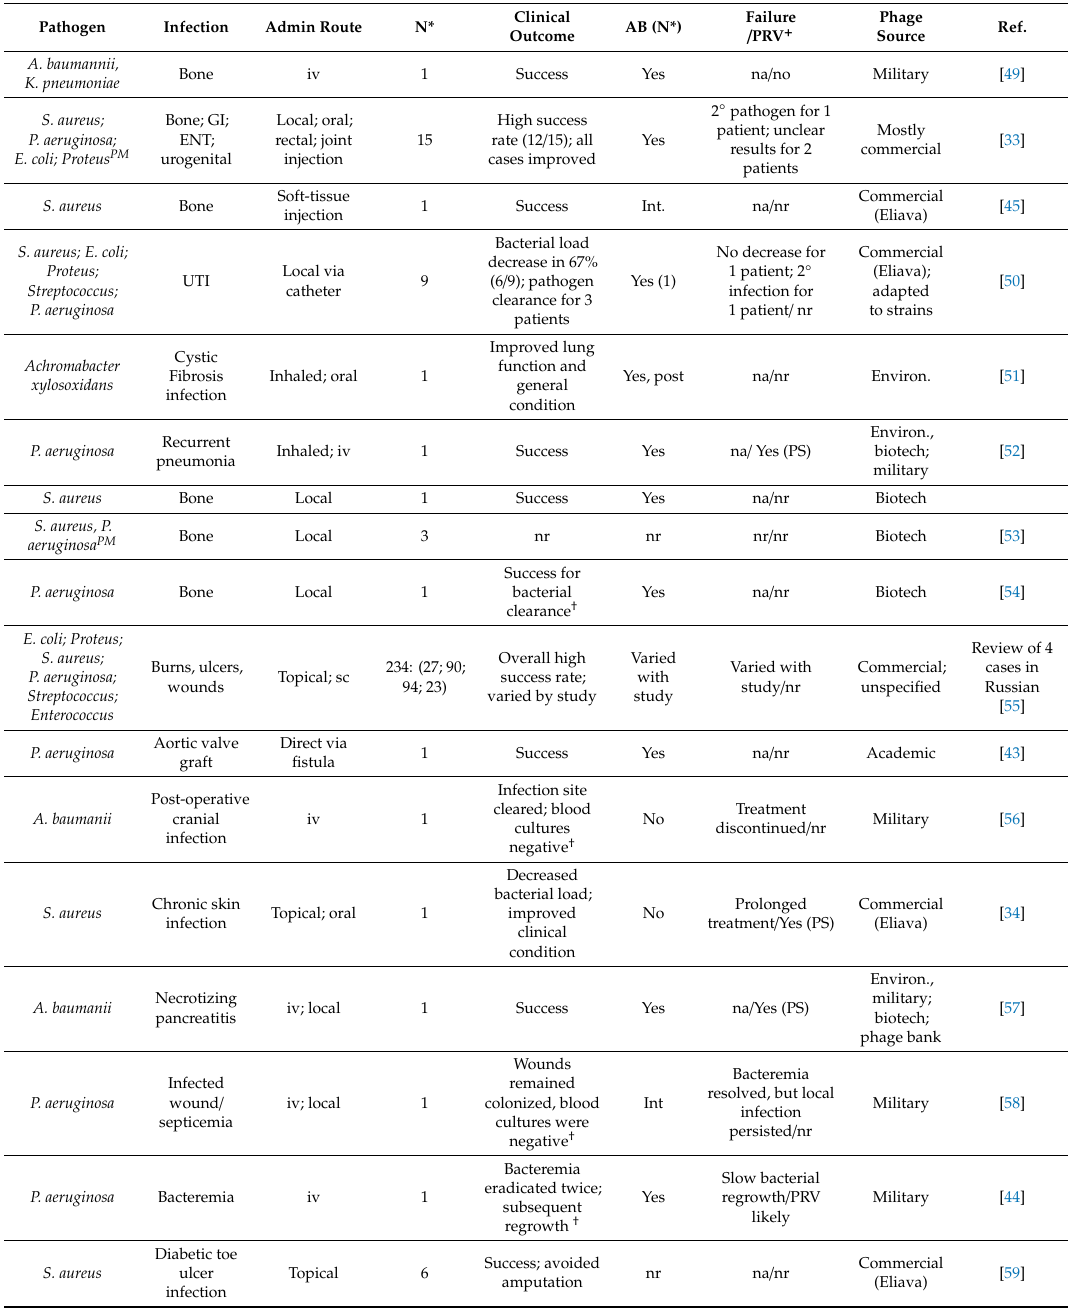
Table 1. Summary of 29 publicly-available, published cases of cPT as of April 2019 in chronological order of most recent publication. Causative pathogens, types of infections (mono / polymicrobial; clinical indication), and administration routes vary between studies. The definition of success may be specific to authors, but overall indicates observed clinical amelioration and / or pathogen clearance. Concomitant antibiotic therapy is indicated for the number of patients per study if ≥ 1. Plausible reasons for cPT failure are listed when available, as well as the investigation into bacterial development of resistance to applied phages. Phage sources used for treatment are listed and further information can be found in cited